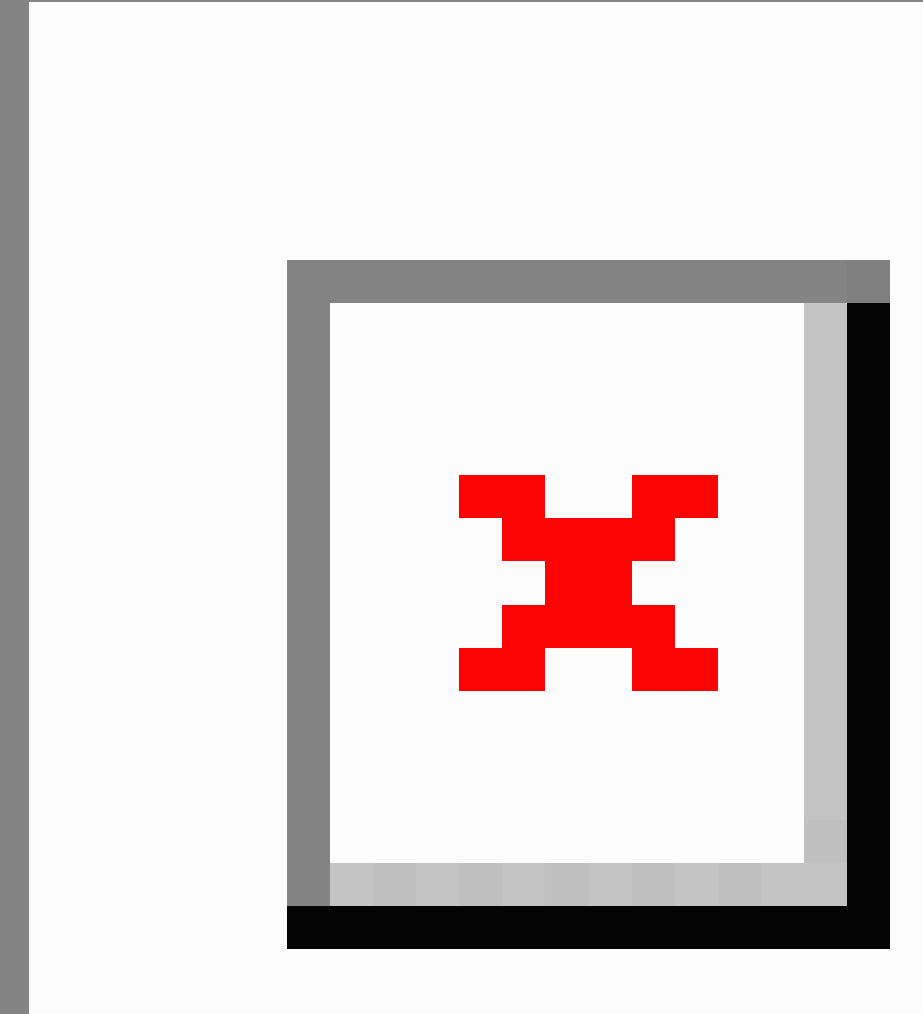
Figure 2. Intervention